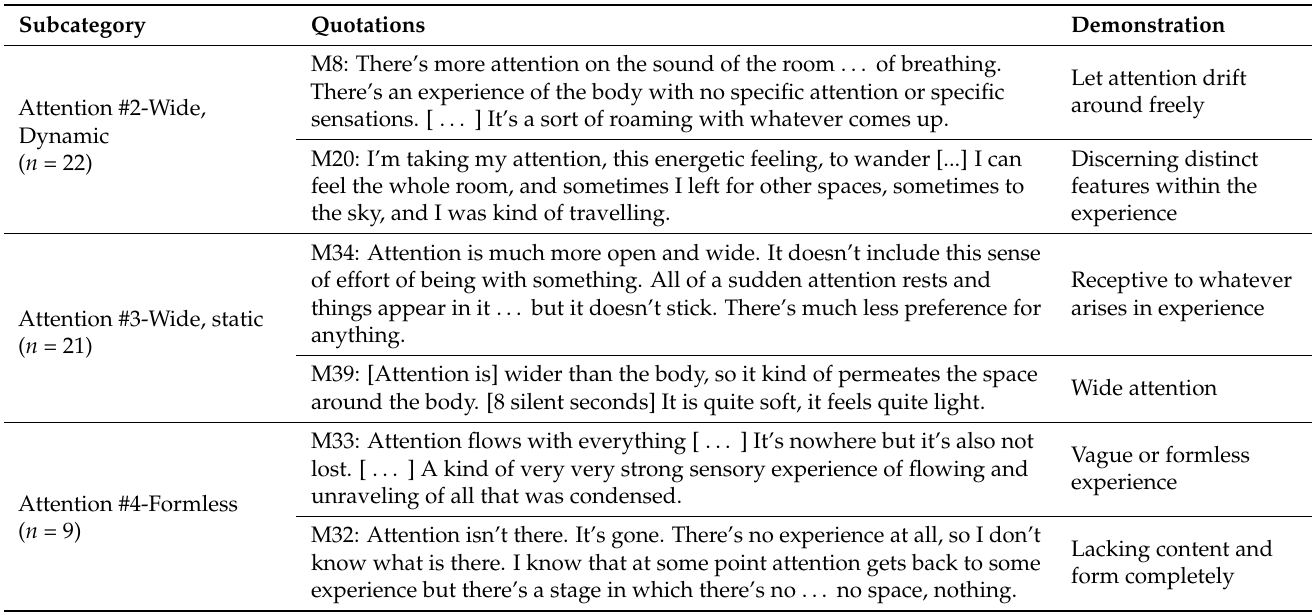
Table 7. SB − representative examples of attentional